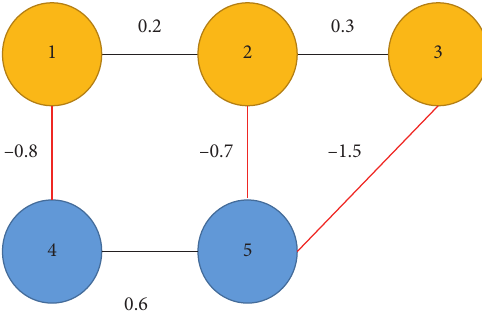
Figure 1: Undirected topology of a multiagent system.